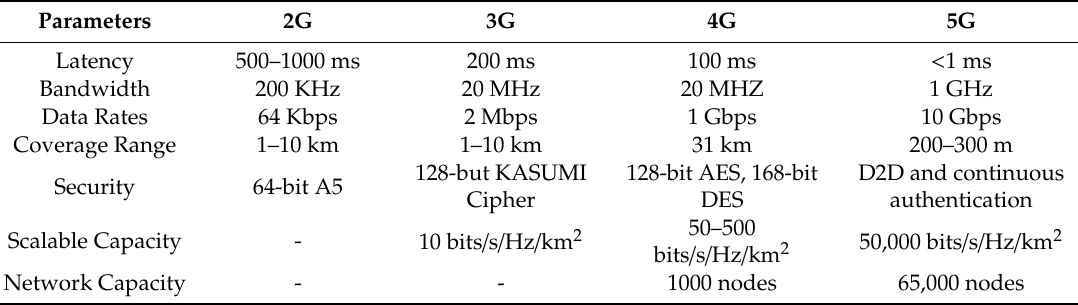
Table 1. Parameters of cellular communication